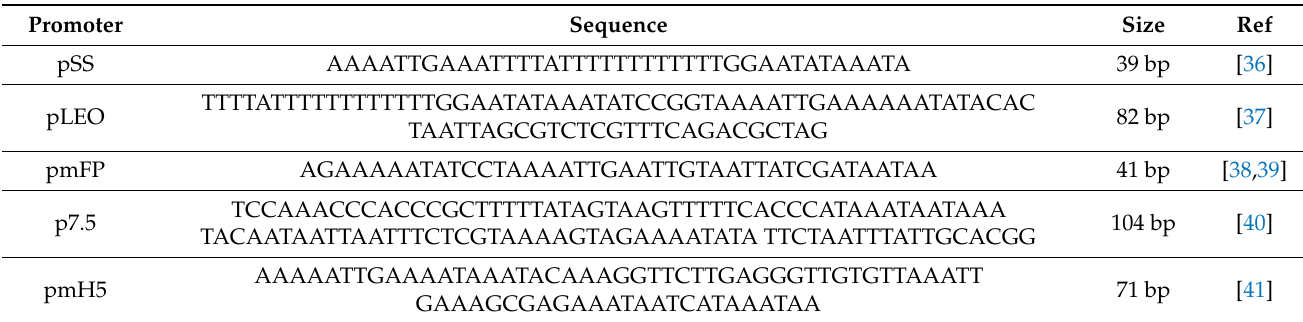
Table 1. Poxvirus promoter